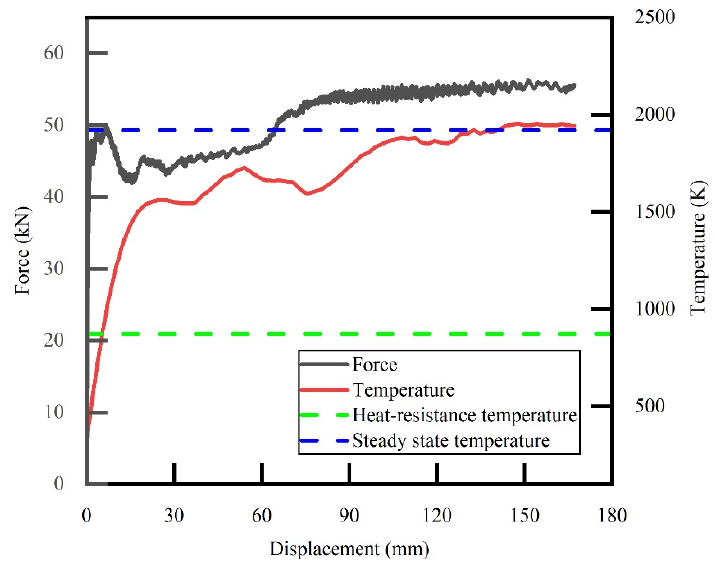
Figure 8. Curves of force and temperature versus displacement.